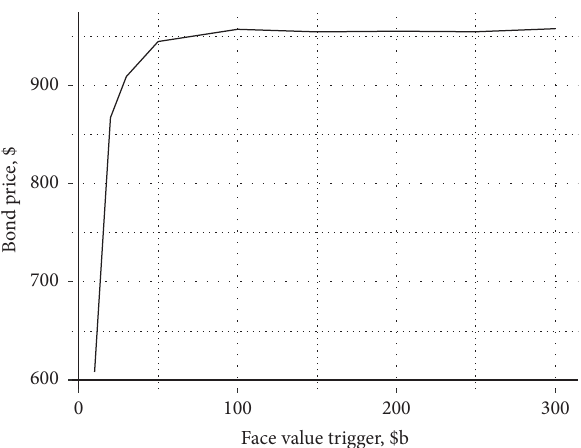
Figure 3: Cyber bond price vs. face value